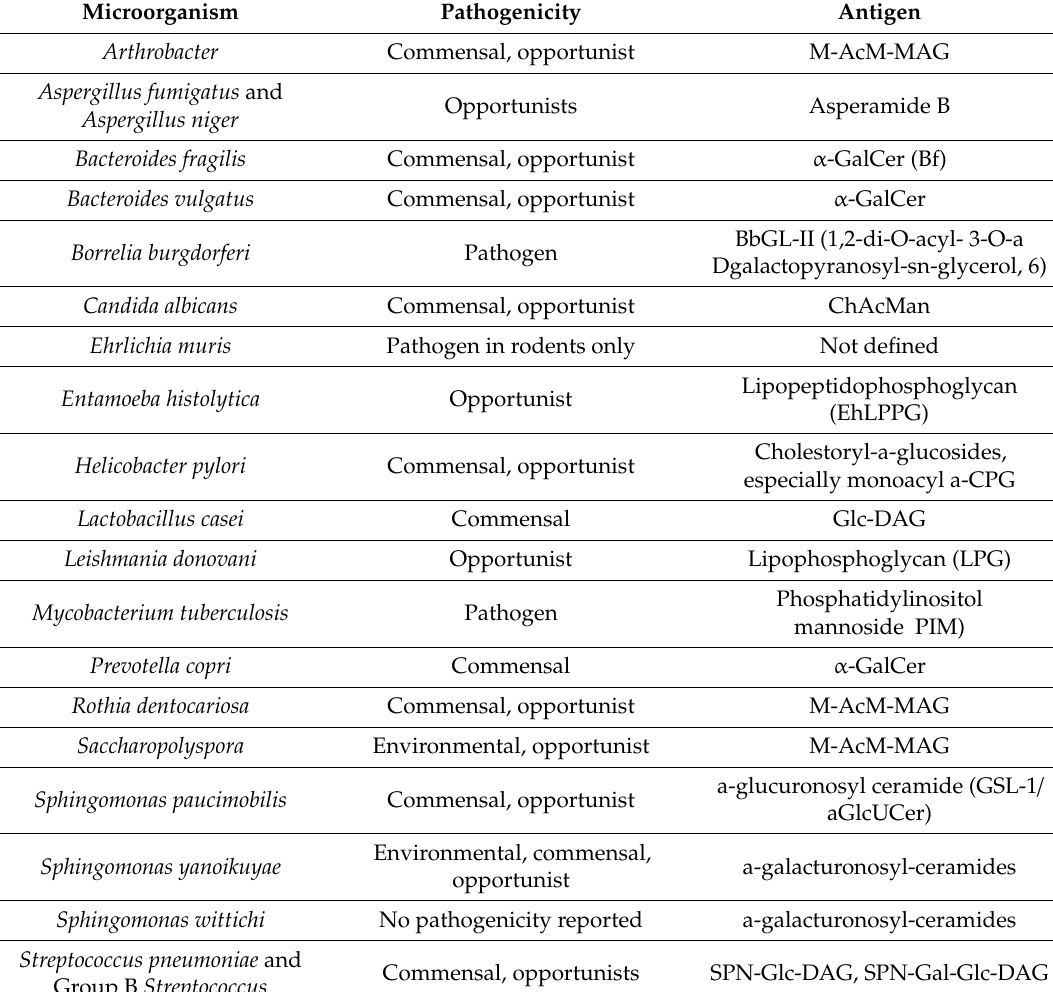
Table 1. Microbial antigens recognized by iNKT cells (adapted from